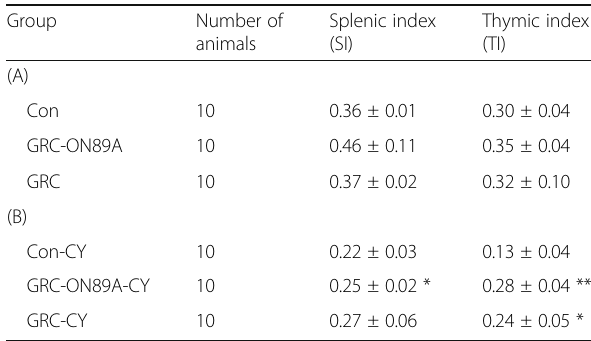
Table 3 Effects of GRC-ON89A on immune organs Group Number of